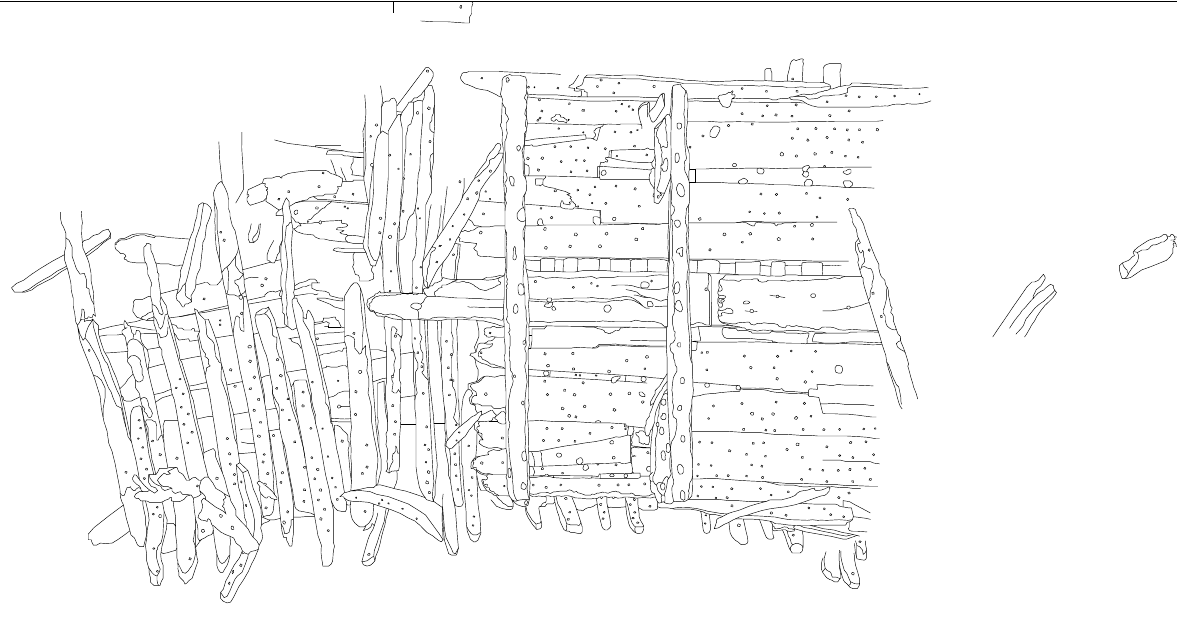
Figure 5. Lines plan of the Straatvaarder wreck, produced in Adobe